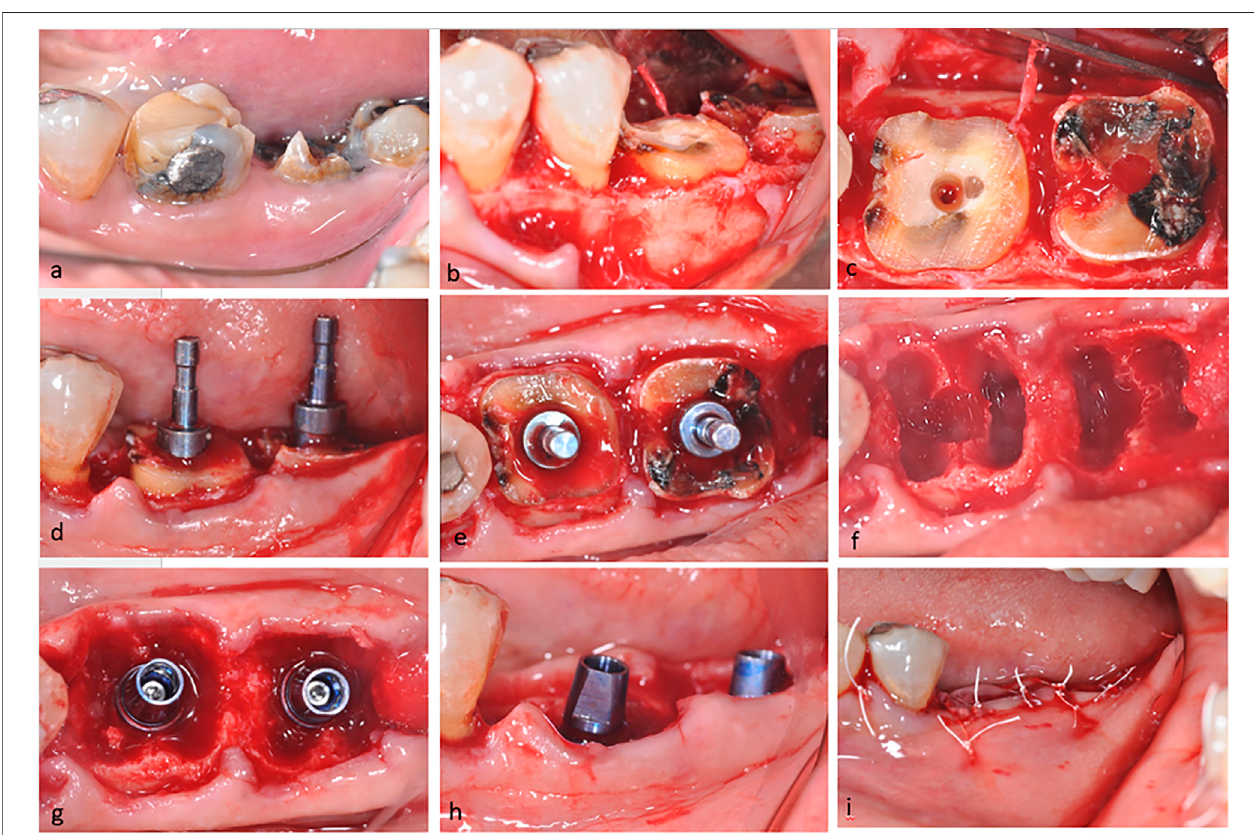
FIGURE 2 | Clinical photographs of the steps in this surgical procedure. (A) Preoperative lateral view of the mandibular left fi rst and second molars, which were unrestorable; (B) clinical view showing fl ap re fl ection and coronectomy; (C) occlusal view showing the dimple created with a #8 round bur; (D,E) lateral and occlusal views showing parallel pins; (F) occlusal view showing the fi nal osteotomy in each molar tooth; (G,H) occlusal and lateral views showing implant placement in the pre- extractive drill; and (I) immediate postoperative lateral view of surgical sites with primary soft tissue